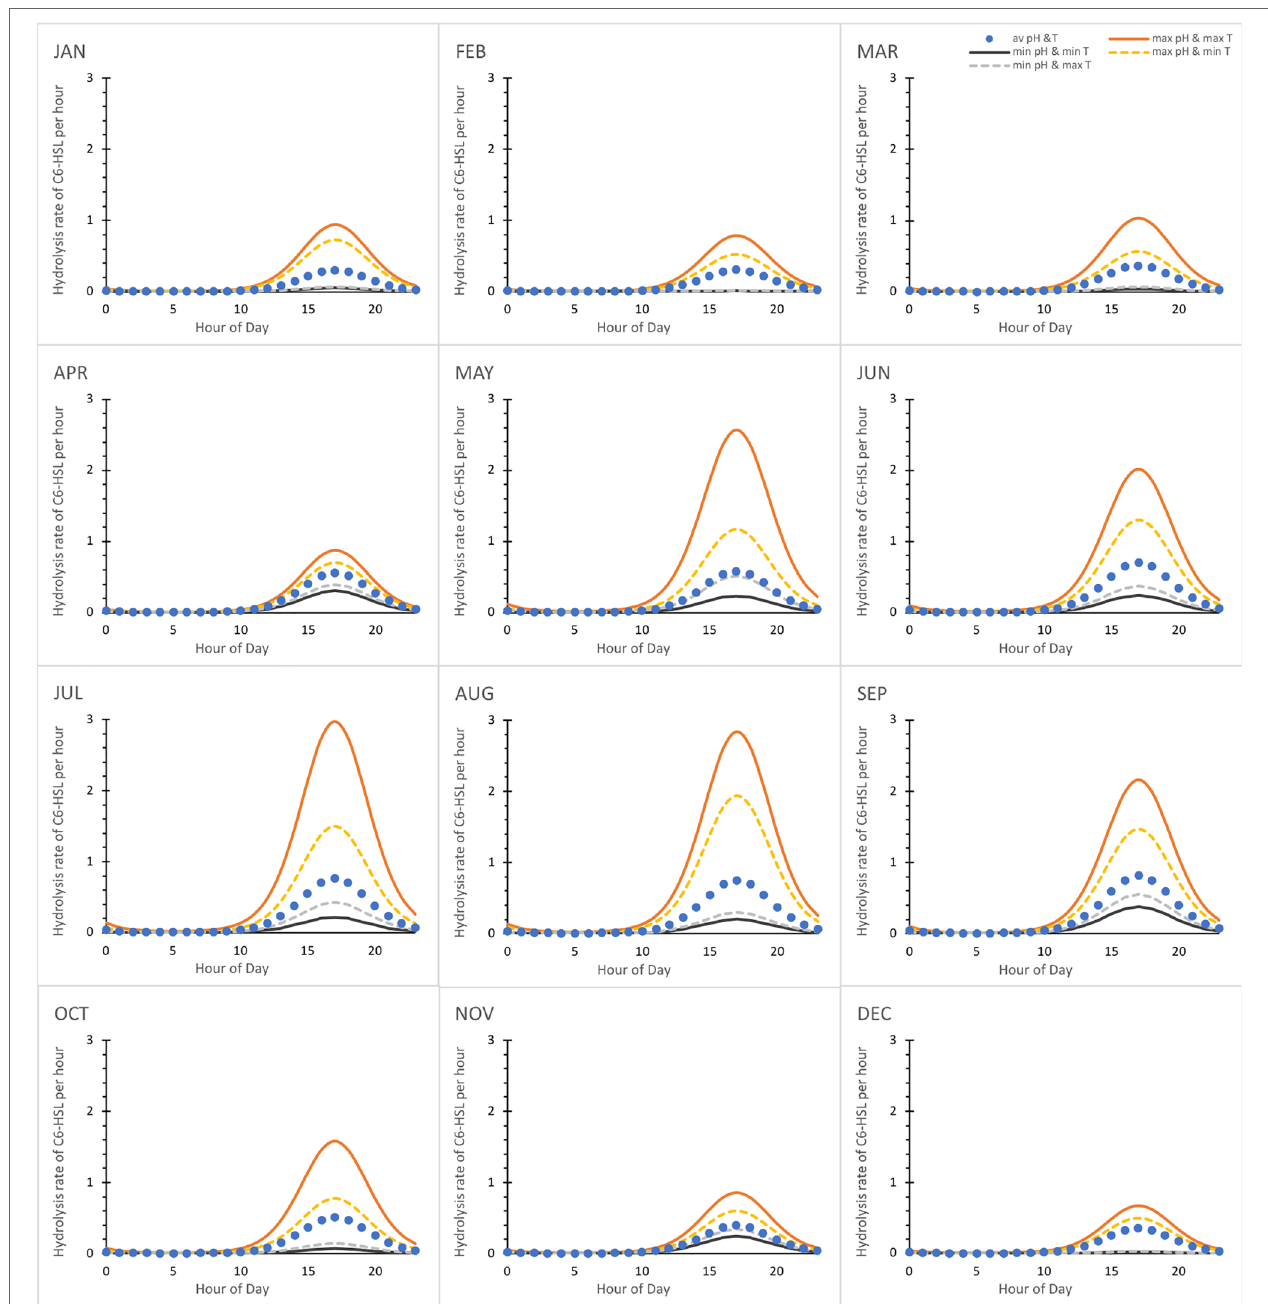
FIGURE 7 | Daily fluctuation of C6-HSL hydrolysis rate for average, minimum and maximum pH and temperature conditions each month. Hydrolysis rate k is given in values per hour and calculated based on equation (16) and the seasonal average, maximum or minimum pH and temperature conditions of the Humber estuary dataset assuming that they translate unchanged to the biofilm as baseline